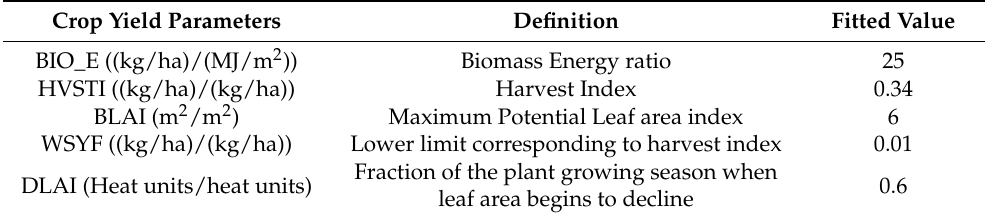
Table 2. Sensitive parameters adjusted during calibration and validation of crop yield. Crop Yield Parameters Definition Fitted